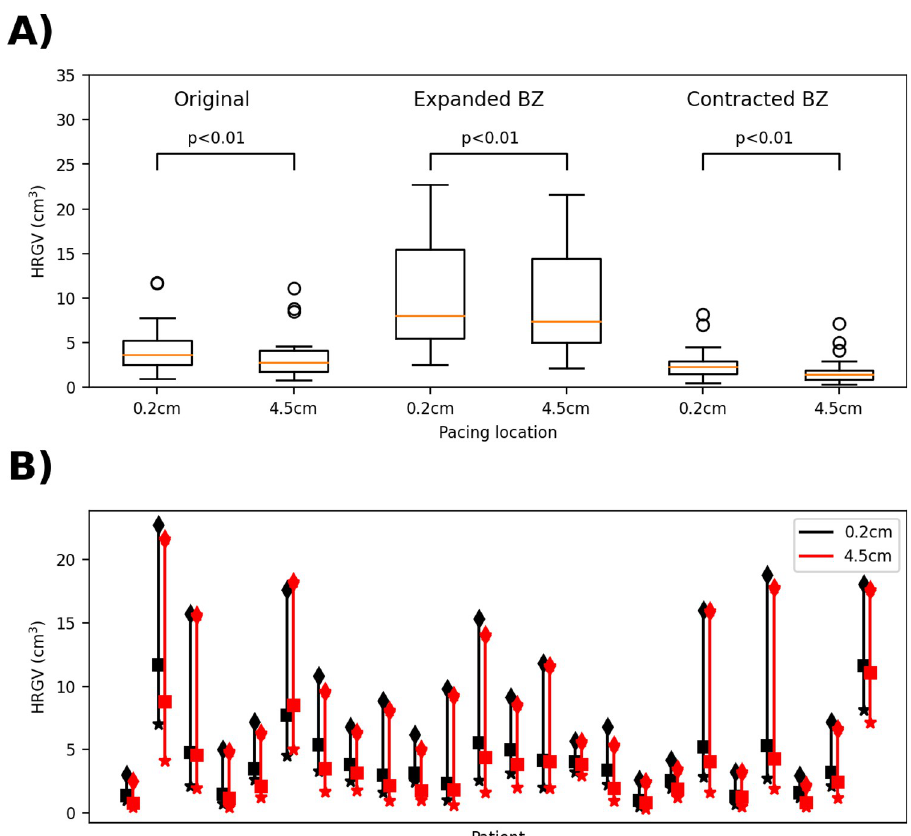
Fig 6. Impact of uncertainty in border zone extent on high repolarization gradient volumes (HRGV). A): boxplots comparing pacing at 0.2cm from scar with pacing 4.5cm from scar for each case. B): Range of HRGV values across each of the three cases (contracted BZ (stars), baseline (squares), expanded BZ (diamonds)) for each patient.